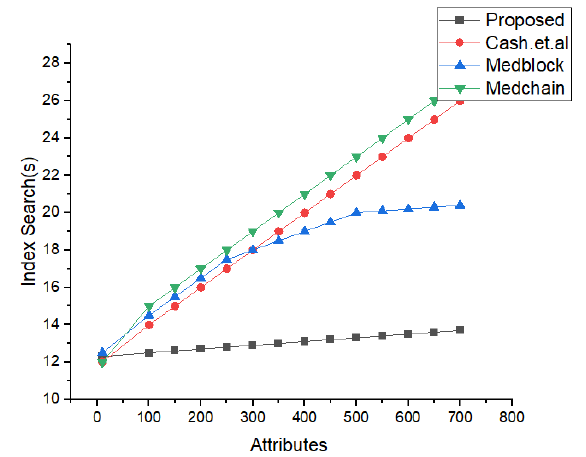
Figure 17. Index Search Based Comparative Analysis.